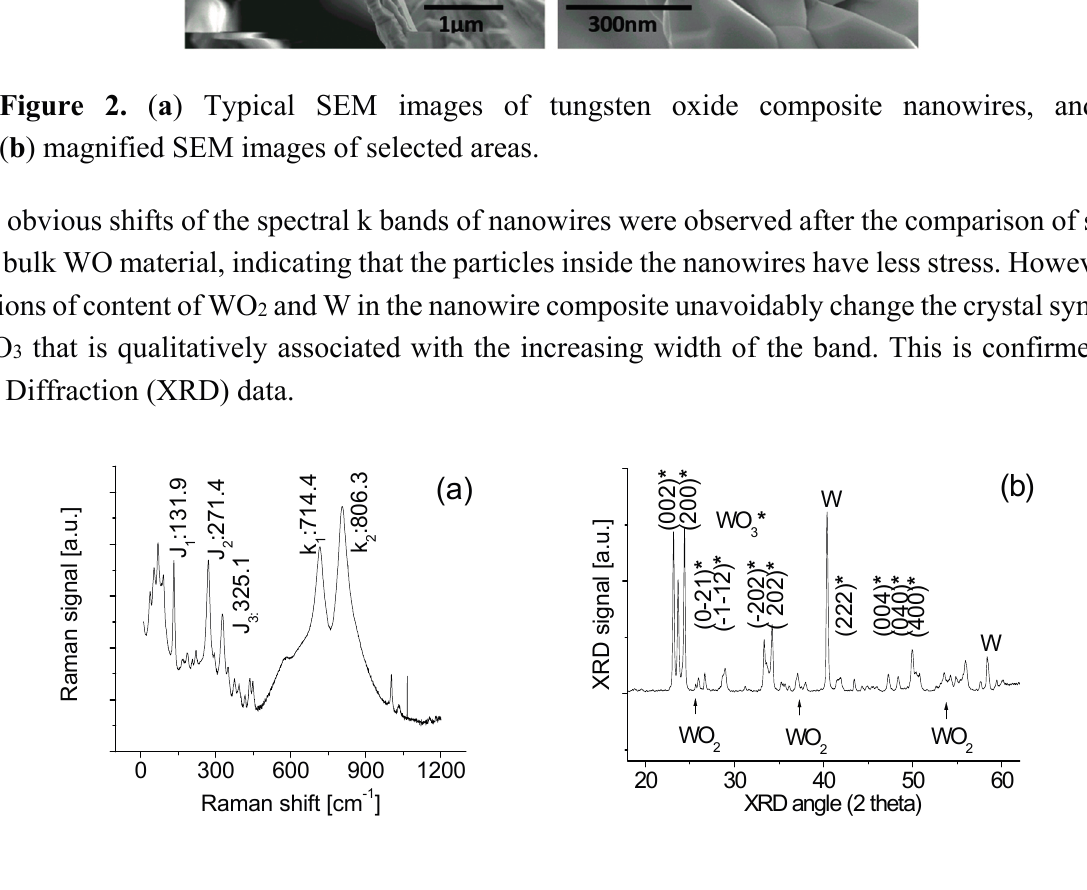
Figure 3. ( a ) Raman; and ( b ) XRD of tungsten oxide composite